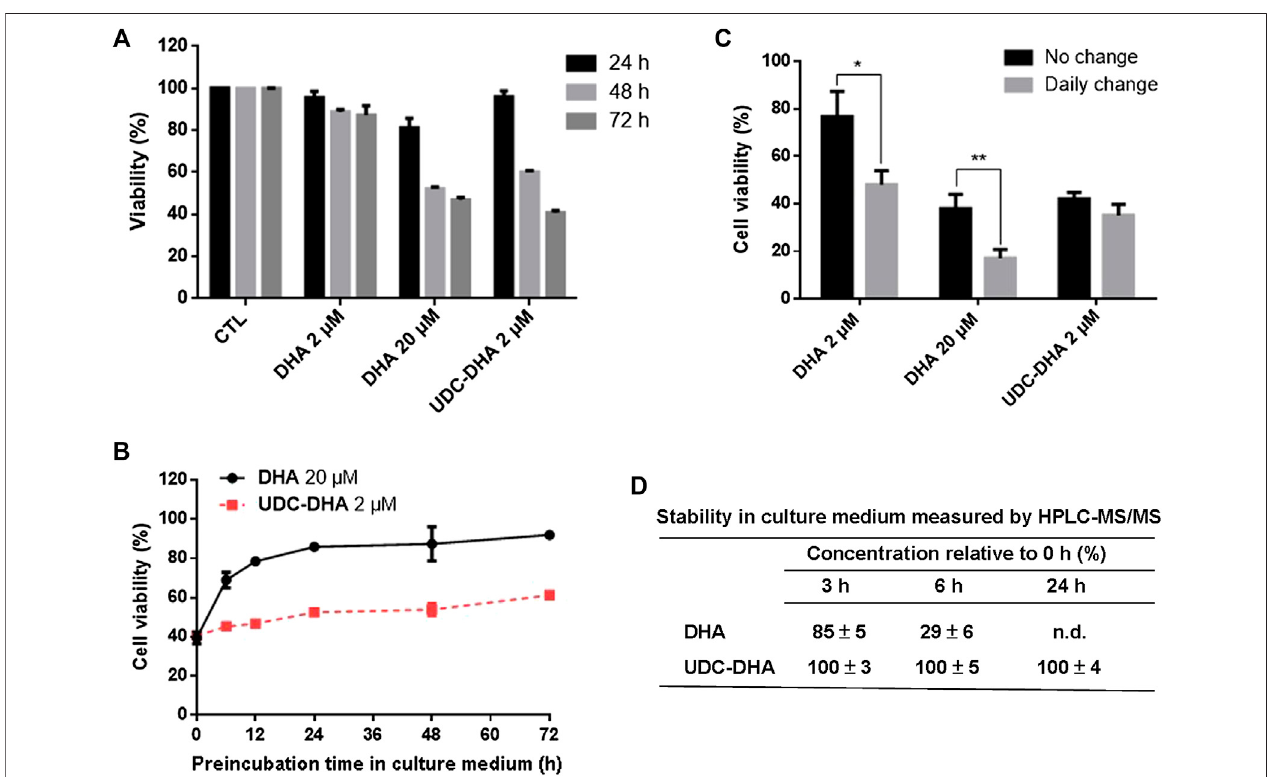
FIGURE 6 | UDC-DHA is more stable than DHA. (A) Time course of the effect of DHA and UDC-DHA on cell viability revealed that UDC-DHA acted gradually and more persistently than DHA. (B) Pre-incubation of DHA but not UDC-DHA in culture medium greatly reduced growth inhibitory effect. DHA and UDC-DHA were incubated in culture medium at 37 ° C for various time periods and then added to HepG2 cells for 72 h, followed by the MTT assay. Results were obtained from at least three independent experiments and data are presented as mean ± SEM. (C) Daily change of culture medium containing DHA but not UDC-DHA signi fi cantly increased the growth inhibitory effect. HepG2 cells were treated with indicated concentrations of DHA or UDC-DHA for 72 h with or without daily change of drug containingmedium and thensubjectedtotheMTTassay.Resultsarepresentedasmean ± SEMofthreeindependent experiments. *, p < 0.05; **, p < 0.01. (D) Stability of DHA and UDC-DHA in cell culture medium measured by HPLC-MS/MS. DHA (20 μ M) or UDC-DHA (2 μ M) was incubated in cell culture medium and 500 μ l aliquots were extracted with ethyl acetate for HPLC-MS/MS analysis. The concentrations of DHA and UDC-DHA at 3, 6 or 24 h were calculated by comparison with that of the 0 h. The data are presented as mean ± SEM of three experiments. n.d., not detected.